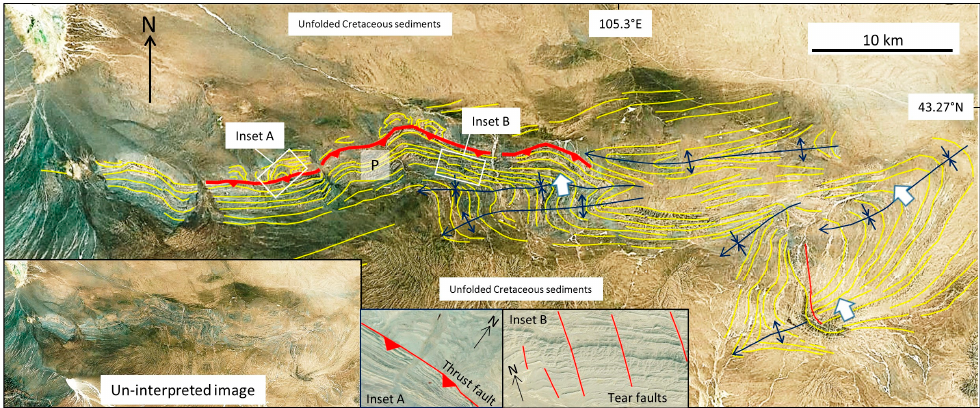
Figure 11. Bing Map image (© 2016 DigitalGlobe ) interpretation showing bedding traces (yellow lines) and major fold hinges in folded and thrusted Permian sequence (P), 50 km southeast of Dalanzadgad, easternmost Gobi Altai. Insets show un-interpreted scene and detail of thrust fault and tear faults. Thick white arrows indicate direction of fold vergence. See Figure 1 for location.